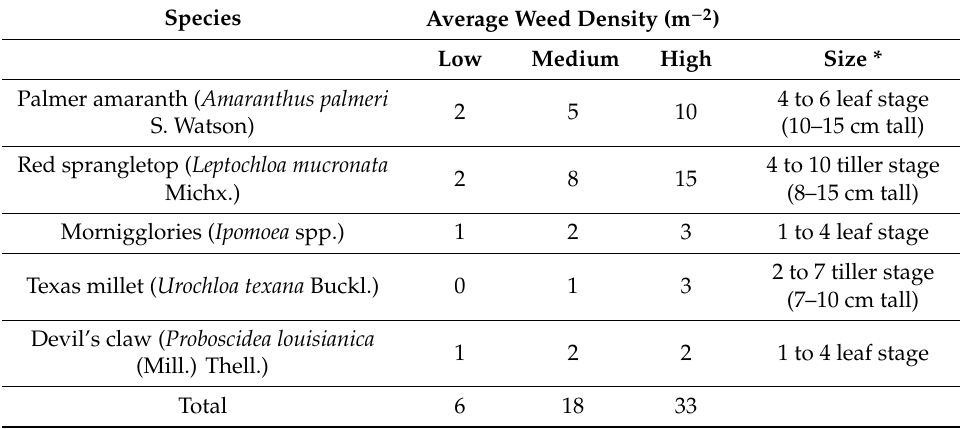
Table 1. Weed infestation levels in the low, medium, and high density plots in the experimental